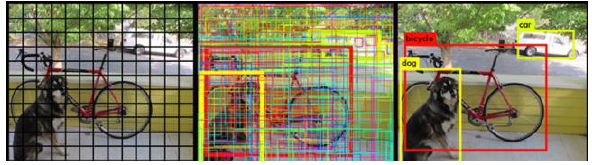
Figure 3. YOLO’s Object Detection Process (taken from pjreddie.com)